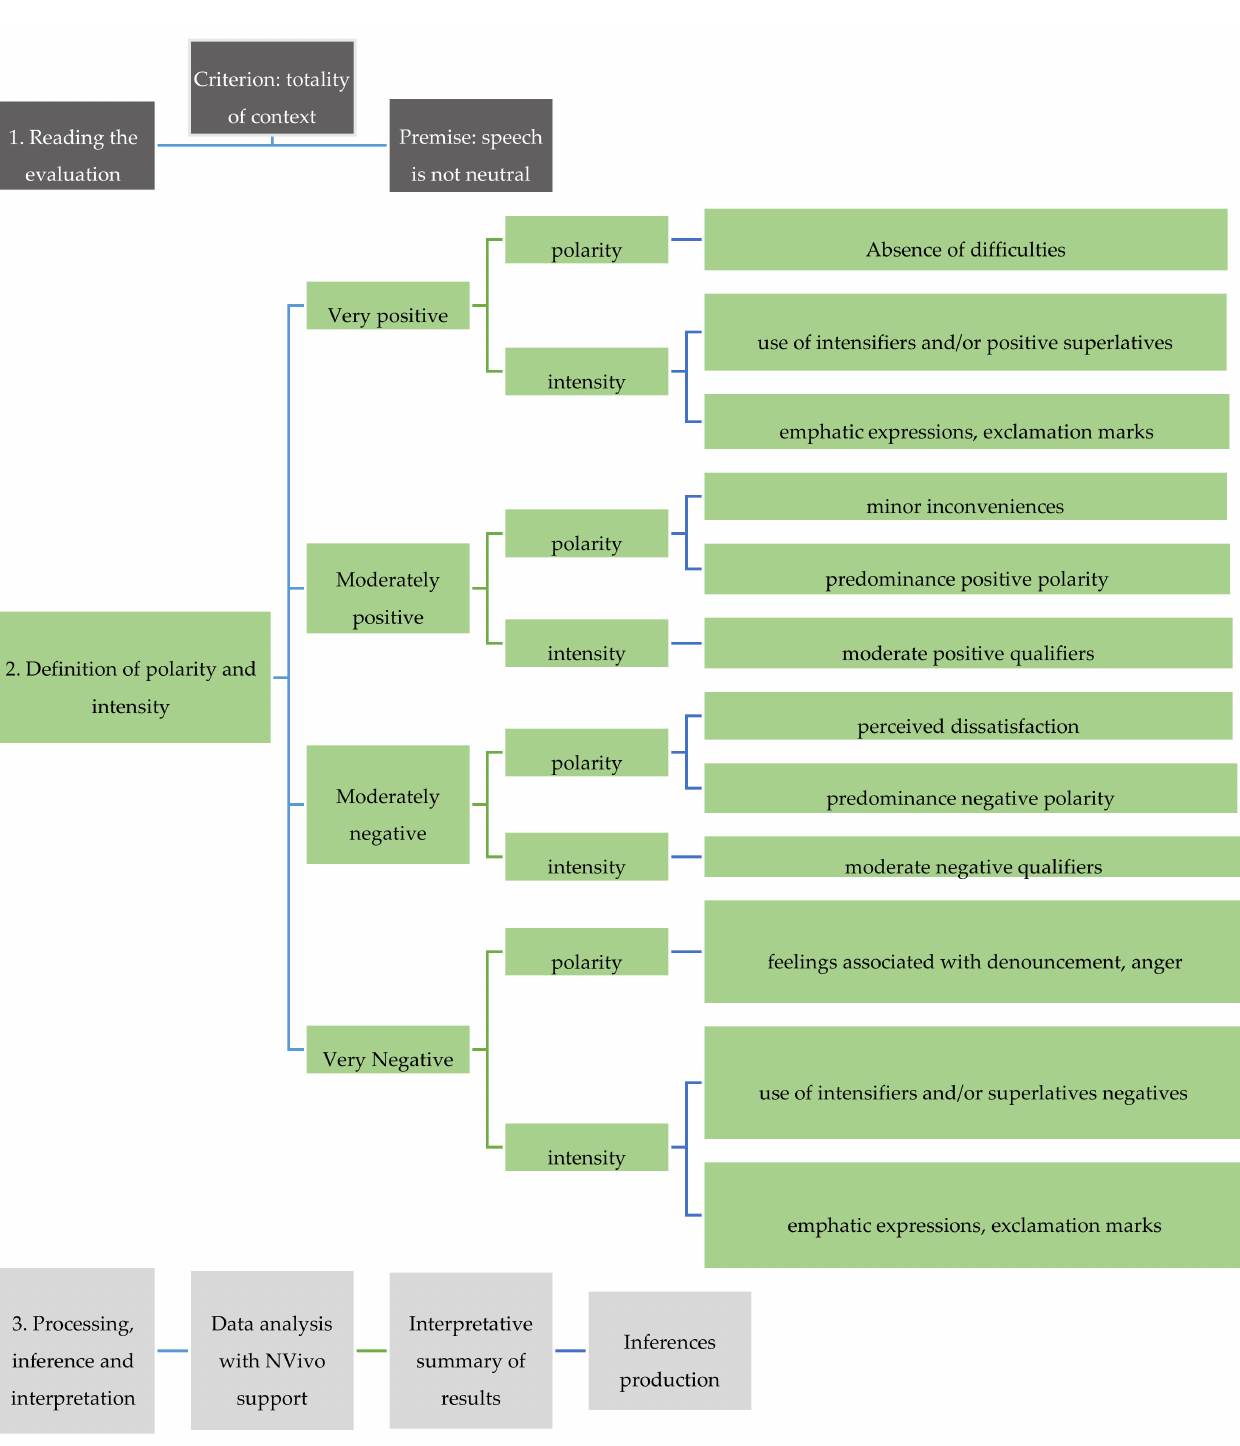
Figure 3. Sentiment analysis